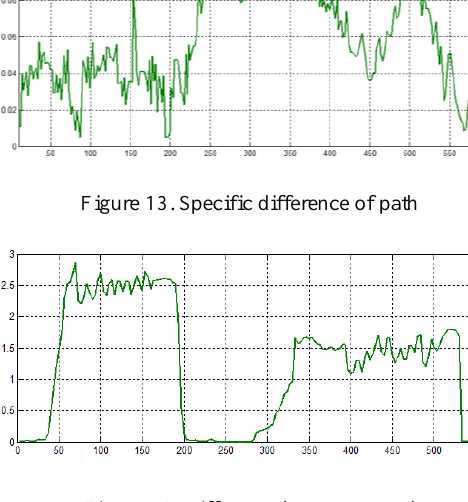
Figure 14. Difference between